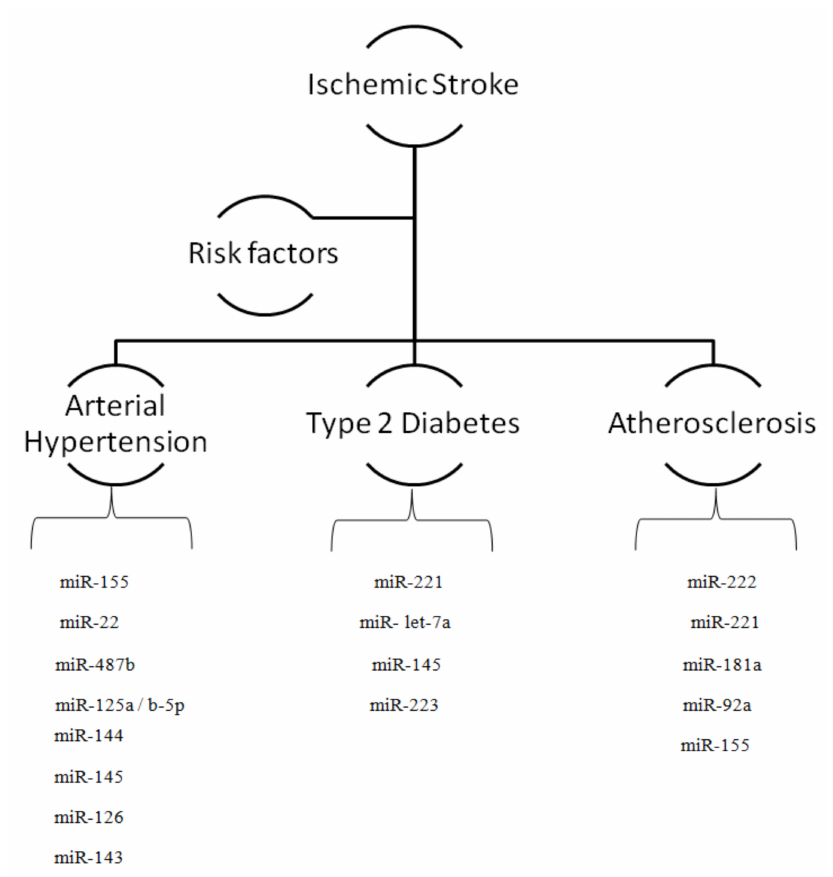
Figure 1. The intricate role of miRNAs in modulating risk factors associated with ischemic